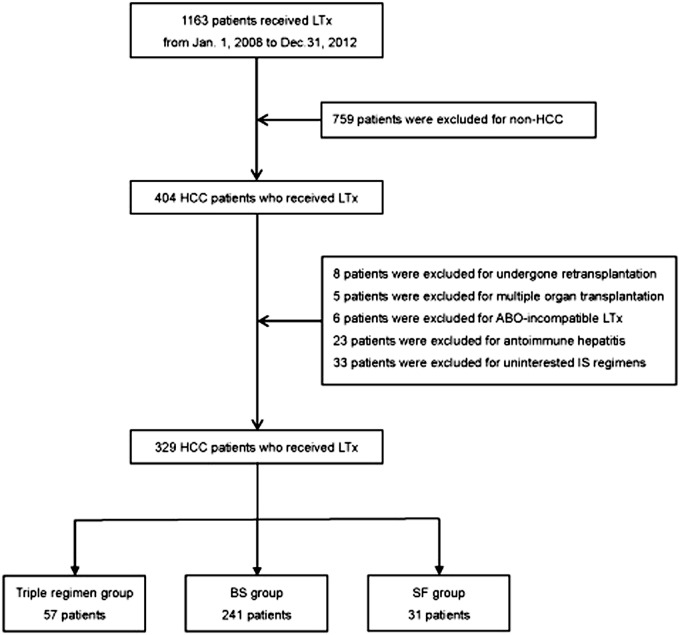
Flow chart of patients selection.